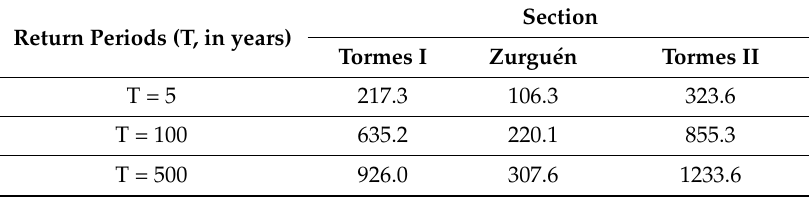
Table 4. Design flows (m 3 /s) for each section in the different return